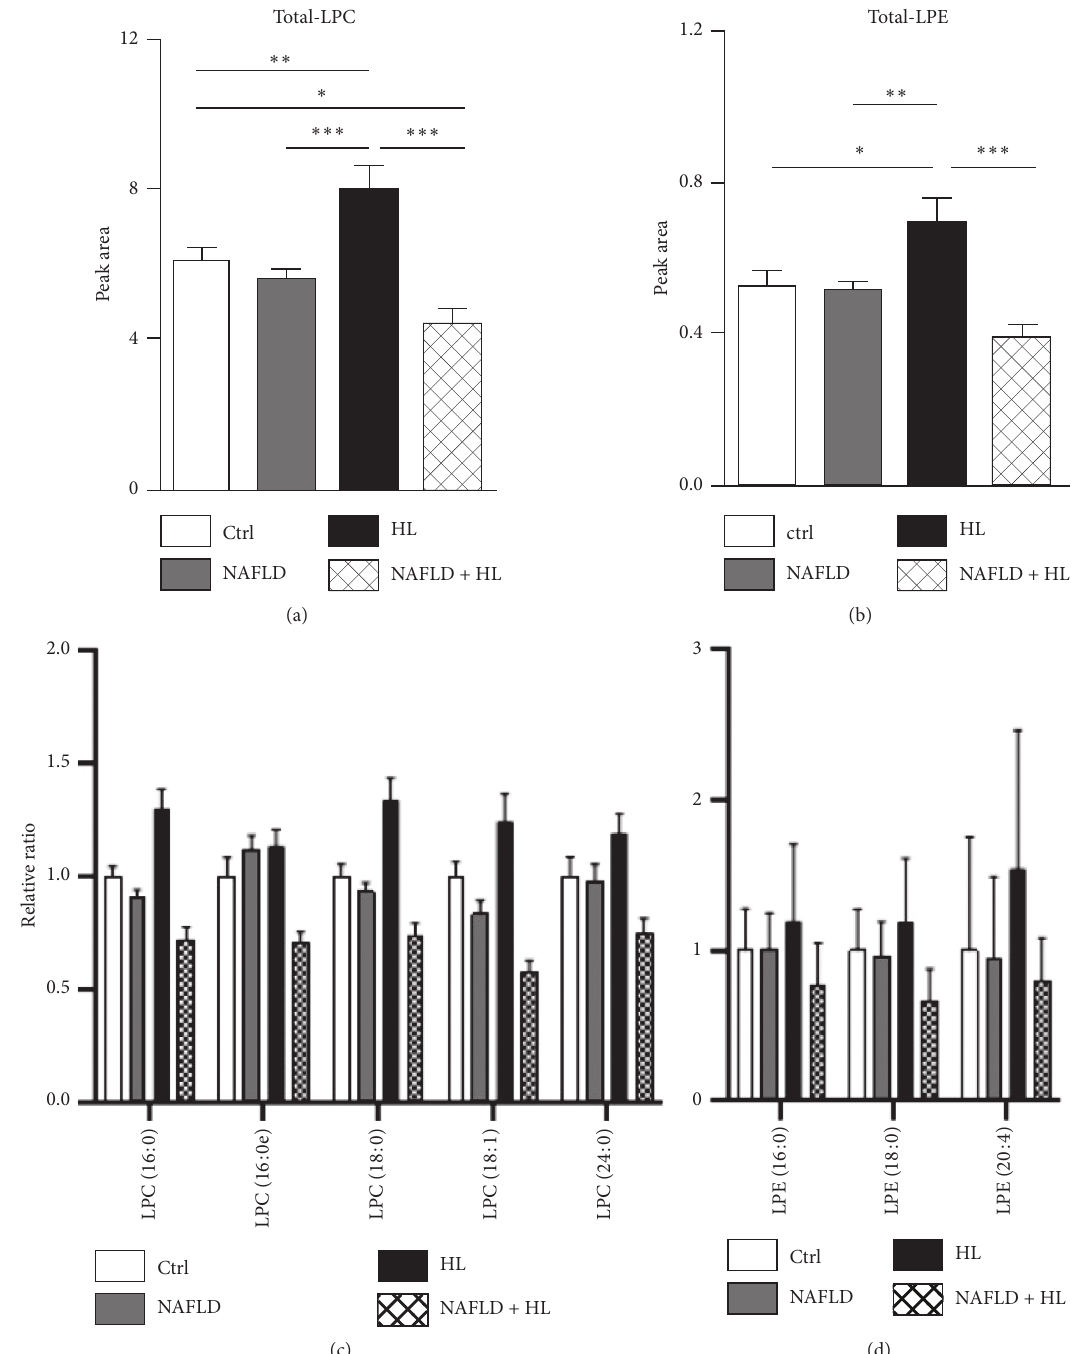
Figure 3: Comparison of the contents of total LPC (a), relative ratio of individual LPC (c), total LPE (b), and relative ratio of individual FFA (d) in the erythrocyte membrane between four groups. Error bars represent the mean ± SD; ∗ p < 0 . 05, ∗∗ p < 0 . 01, ∗∗∗ p < 0 .